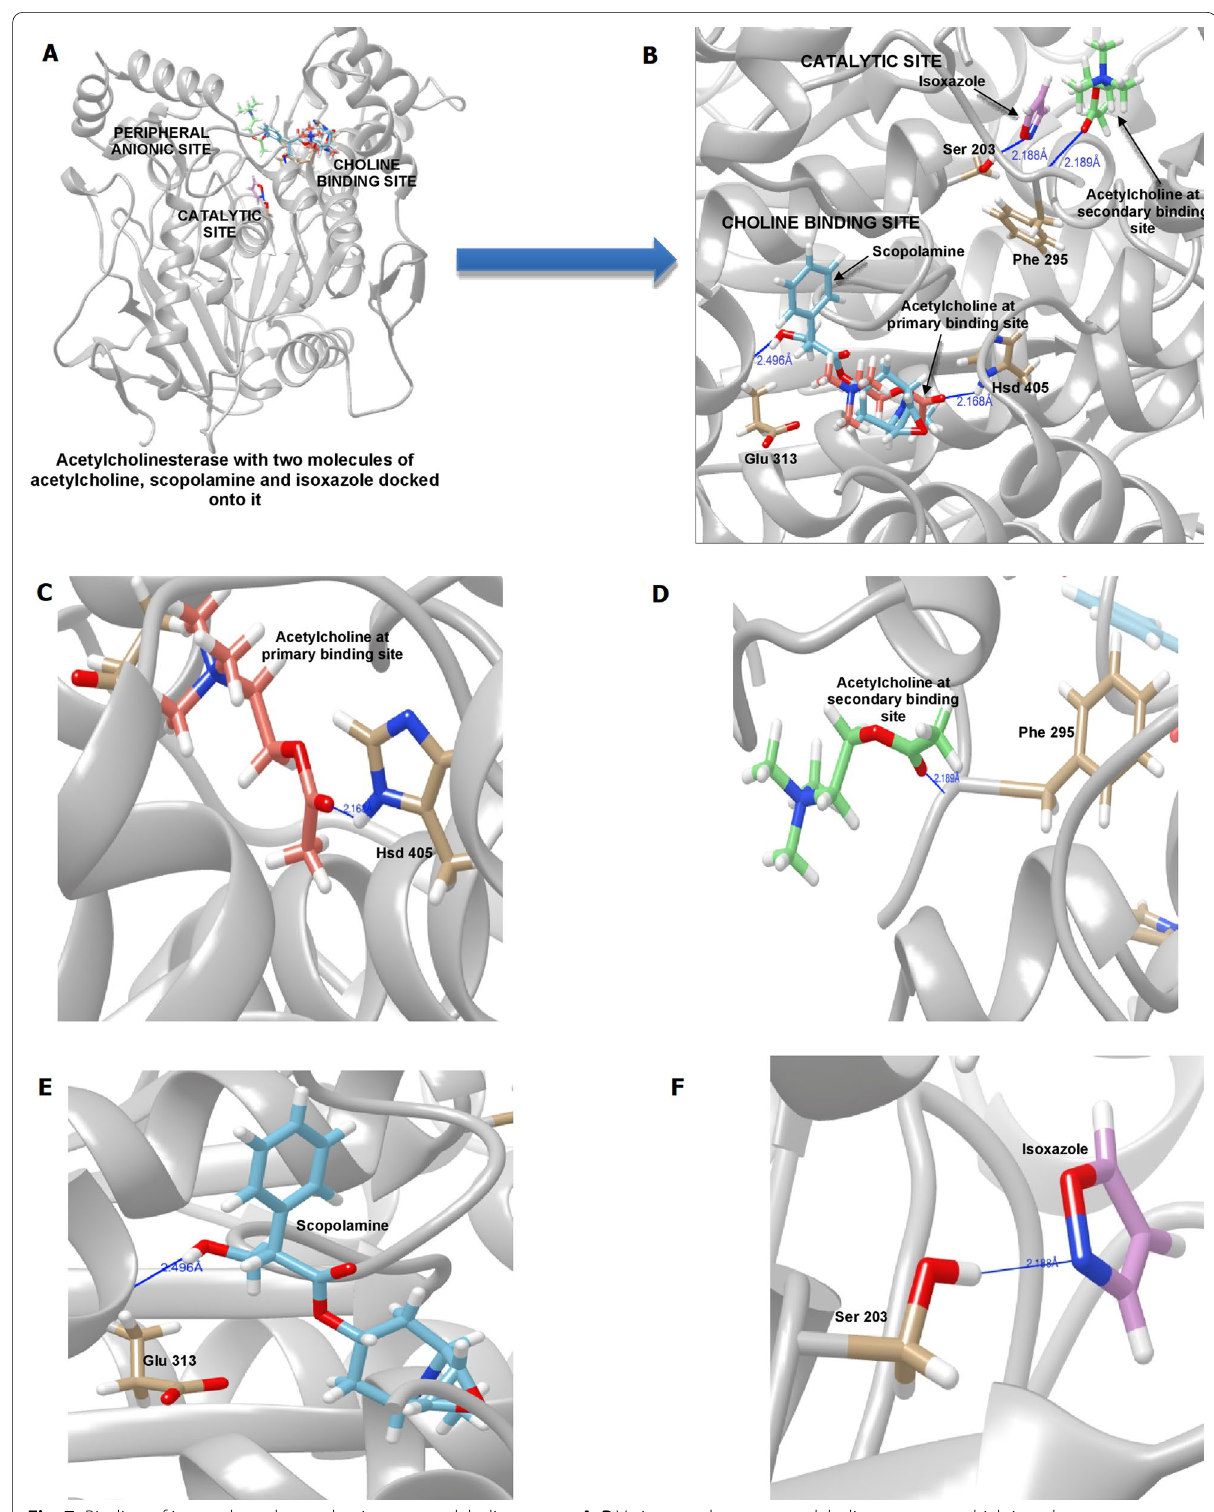
Fig. 7 Binding of isoxazole and scopolamine to acetylcholinesterase. A , B Various pockets on acetylcholinesterase to which its substrate acetylcholine, isoxazole and scopolamine were bound, C Acetylcholine at Hsd405, the primary binding site, in the choline-binding pocket, D Acetylcholine at Phe295, the secondary binding site, near the catalytic site, E Scopolamine at Glu313 in the choline-binding pocket, F Isoxazole binding Ser203, a catalytic triad